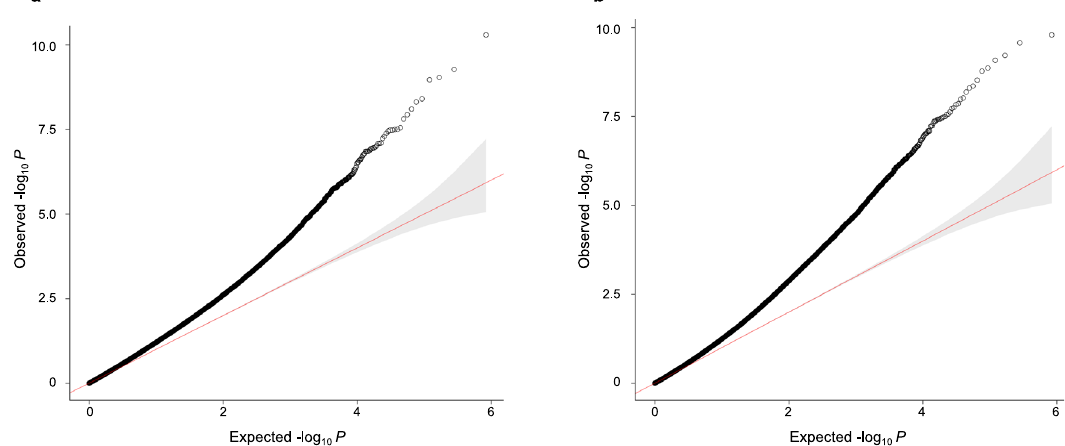
Fig. 1 QQ-plots of the meta-analyses of the association between maternal ppBMI and placental DNAm. Analyses were carried out a adjusting for putative cellular heterogeneity or b without adjusting for putative cellular heterogeneity ( N = 2631 placental DNA samples). The red line represents the normal distribution and 95% con fi dence interval (gray